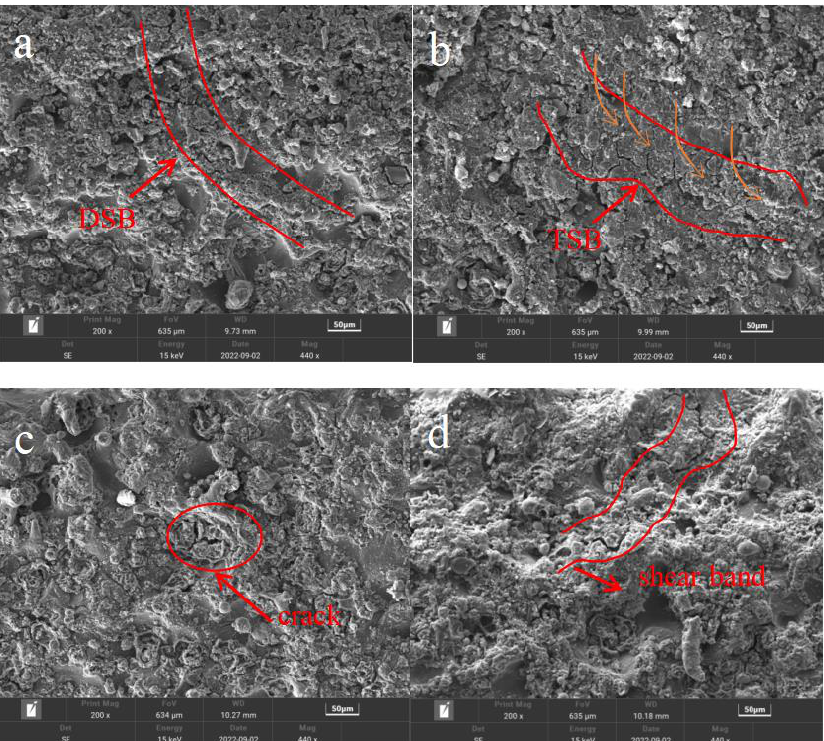
Figure 11. Partial enlargement of adiabatic shear band ( a ): 298.15 K, 6000 S − 1 , ( b ): 373.15 K, 6000 S − 1 , ( c ): 373.15 K, 7000 S − 1 , ( d ): 473.15 K, 7500 S − 1